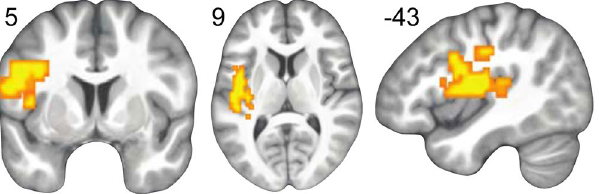
Figure 3. Positive correlation between ventral striatum D2 BP ND and subjective value in the left inferior frontal gyrus, whole brain cluster-forming threshold Z > 2.3, cluster-corrected p < 0.05 shown on the mean participant T1-weighted image in MNI space.